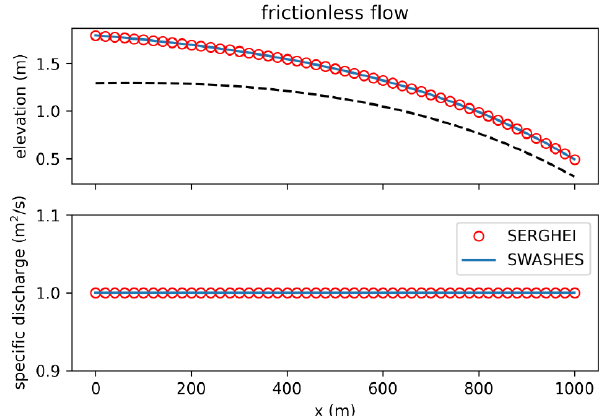
Figure A4. Analytical steady flows: flumes. SERGHEI-SWE cap- tures moving equilibrium solution for frictionless test case, with a stable and well-balanced solution.